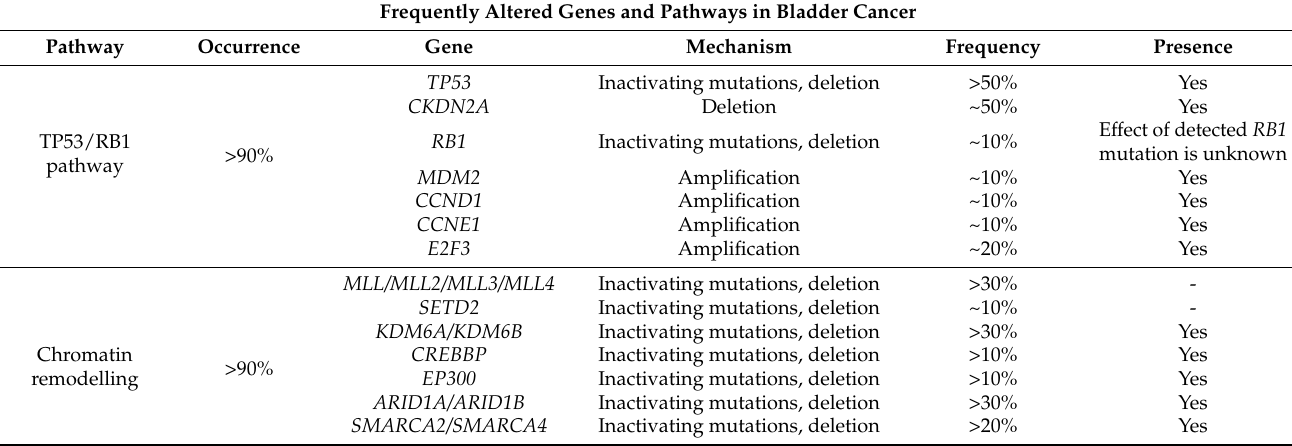
Table A2. A complete list of manually analysed genes (an adaptation from Young Seok Ju